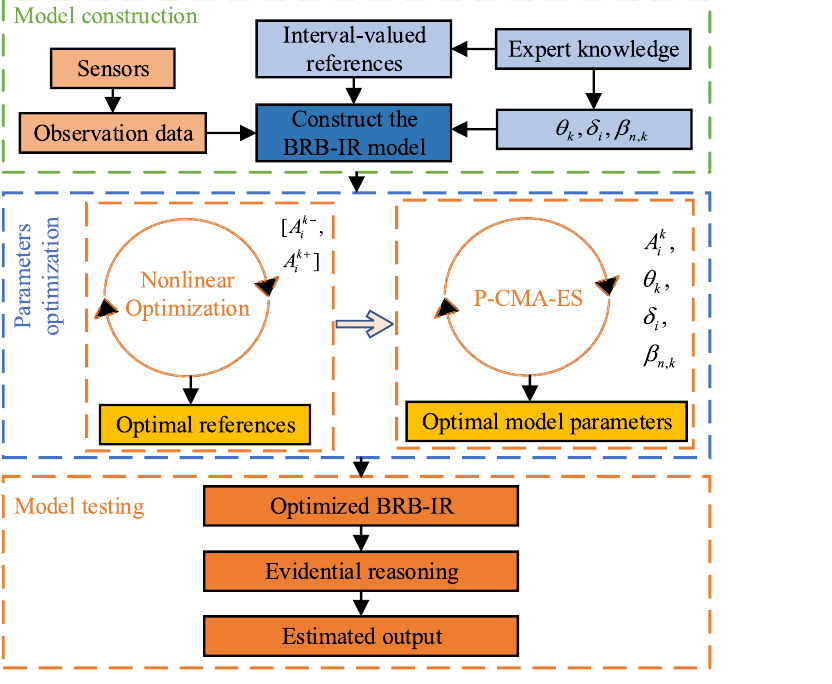
Figure 2. The implementation procedures of the